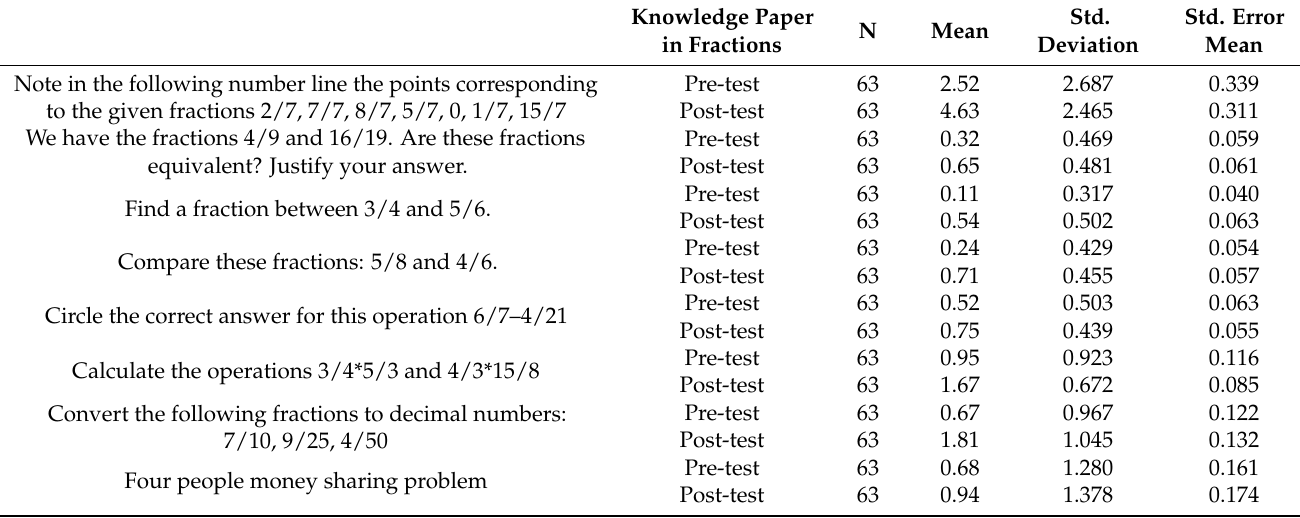
Table 4. Performance testing of dyslexic students in each question who participated in the